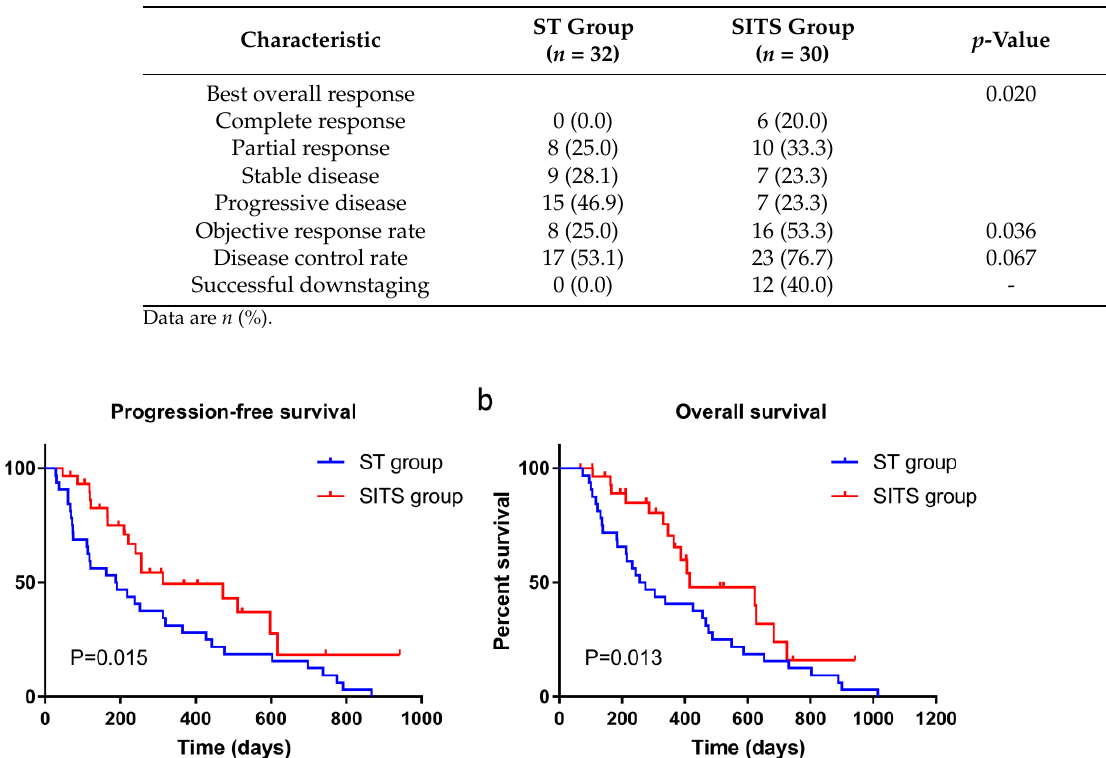
Table 3. Univariable and multivariable analyses of risk factors for PFS in advanced HCC cases accompanied by PVTT.